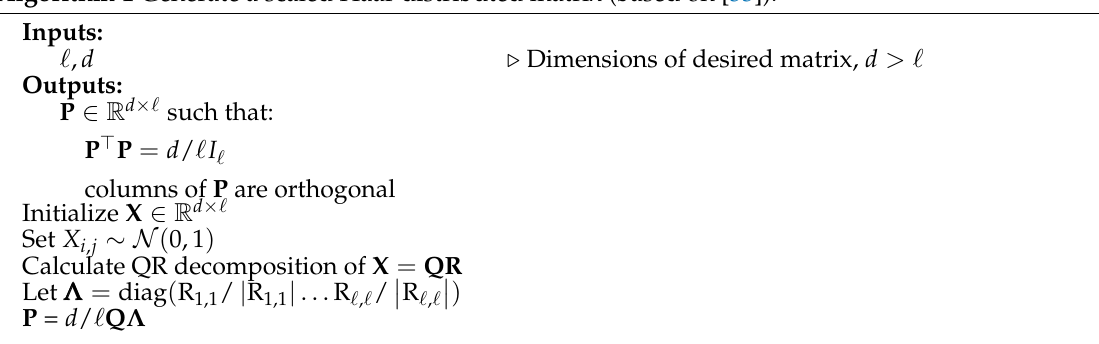
Algorithm 1 Generate a scaled Haar distributed matrix (based on [33]).